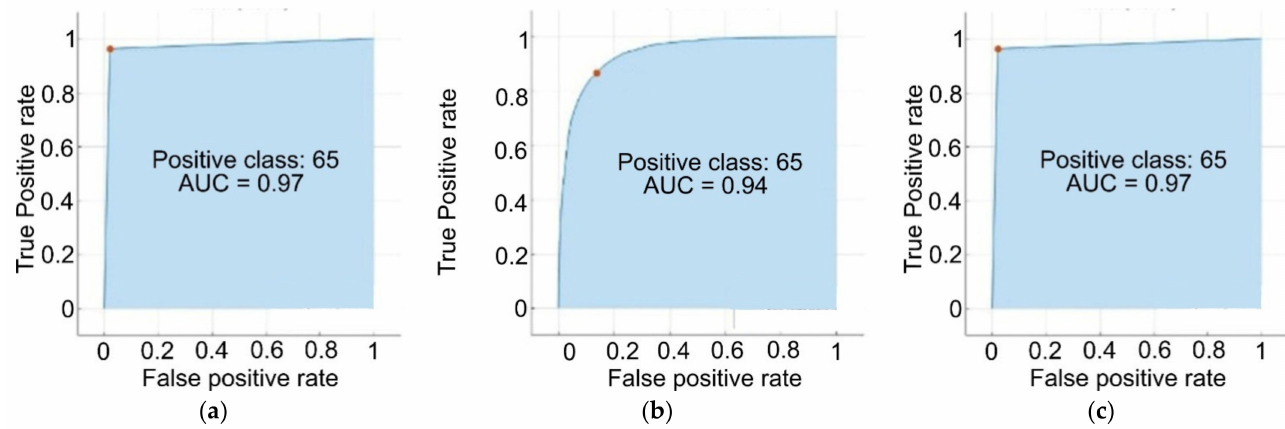
Figure 5. ROC on five-fold validation ( a ) Fine KNN; ( b ) WNN; ( c )